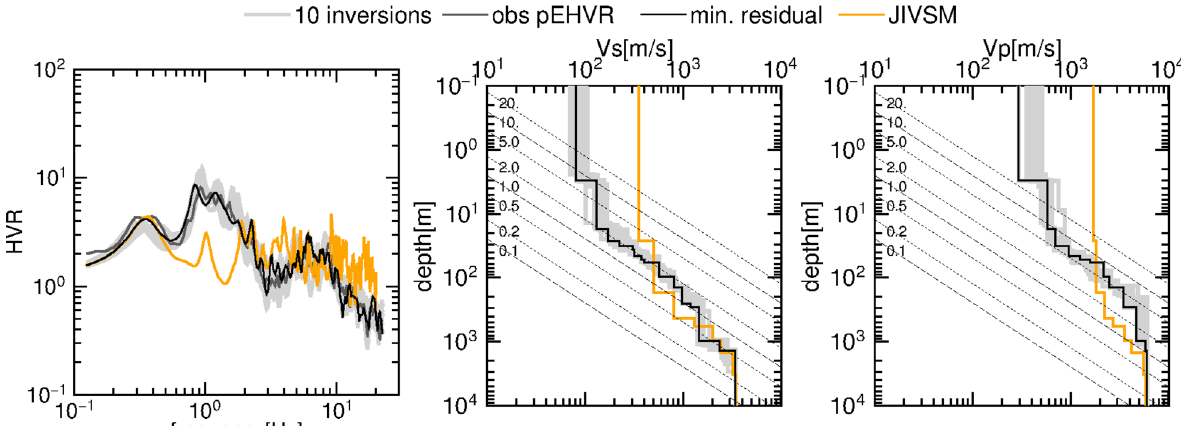
Fig. 3 Comparisons of the theoretical EHVRs by the inverted models with the observed EHVR on the left and the resultant S-wave and P-wave velocity profiles on the right. Light gray lines are the results of ten trials and the black lines are the best among them. Orange lines are those of the JIVSM structure close to KUMA (Koketsu et al. 2012). The inclined dashed and dotted lines on velocity models show resonant frequencies of the corresponding layer interfaces based on one quarter wavelength law